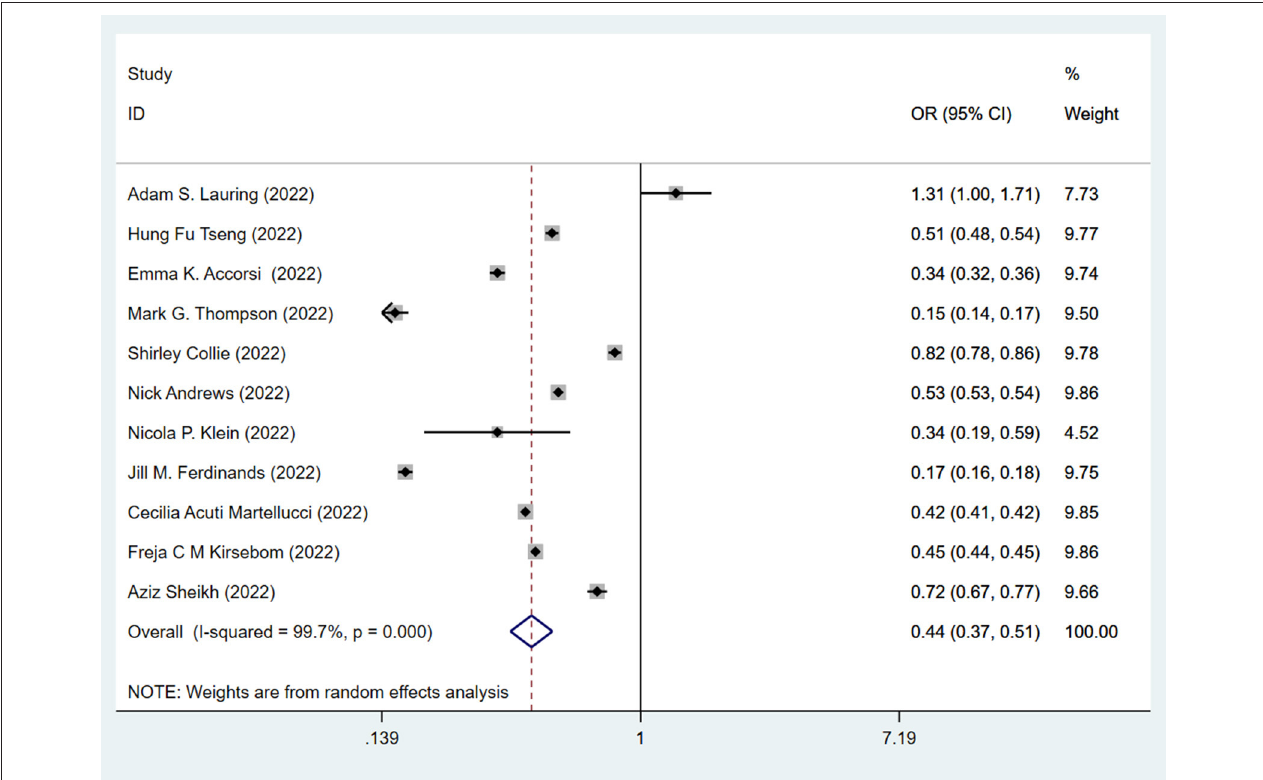
FIGURE 3 | Effectiveness of the three doses COVID-19 vaccines against the Omicron variant compared to the unvaccination.